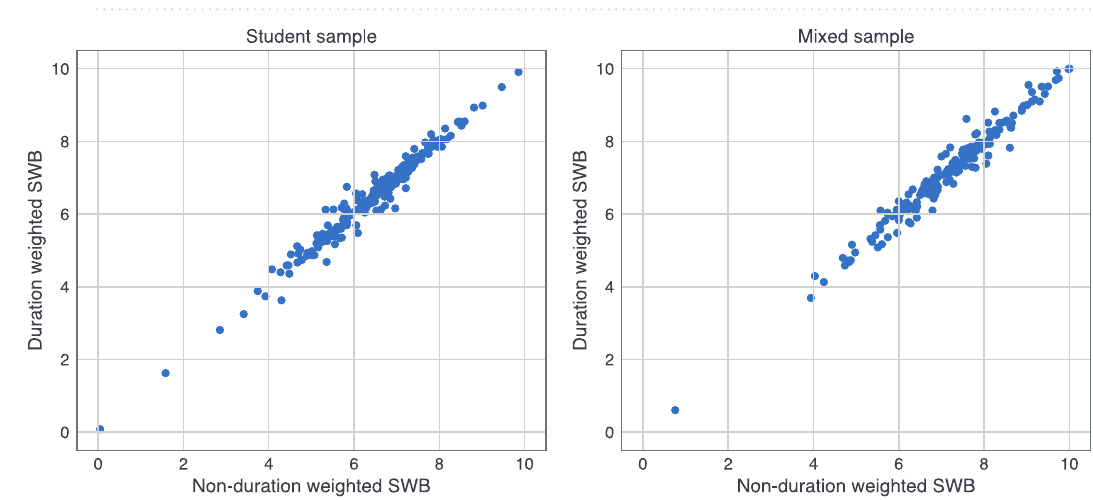
Figure 2. Scatter plots showing total reported SWB (happiness intensity × duration) scores per individual, with and without duration weights, reported in the EMA questionnaire. The figure on the left represents the student sample and the figure on the right represents the mixed sample.